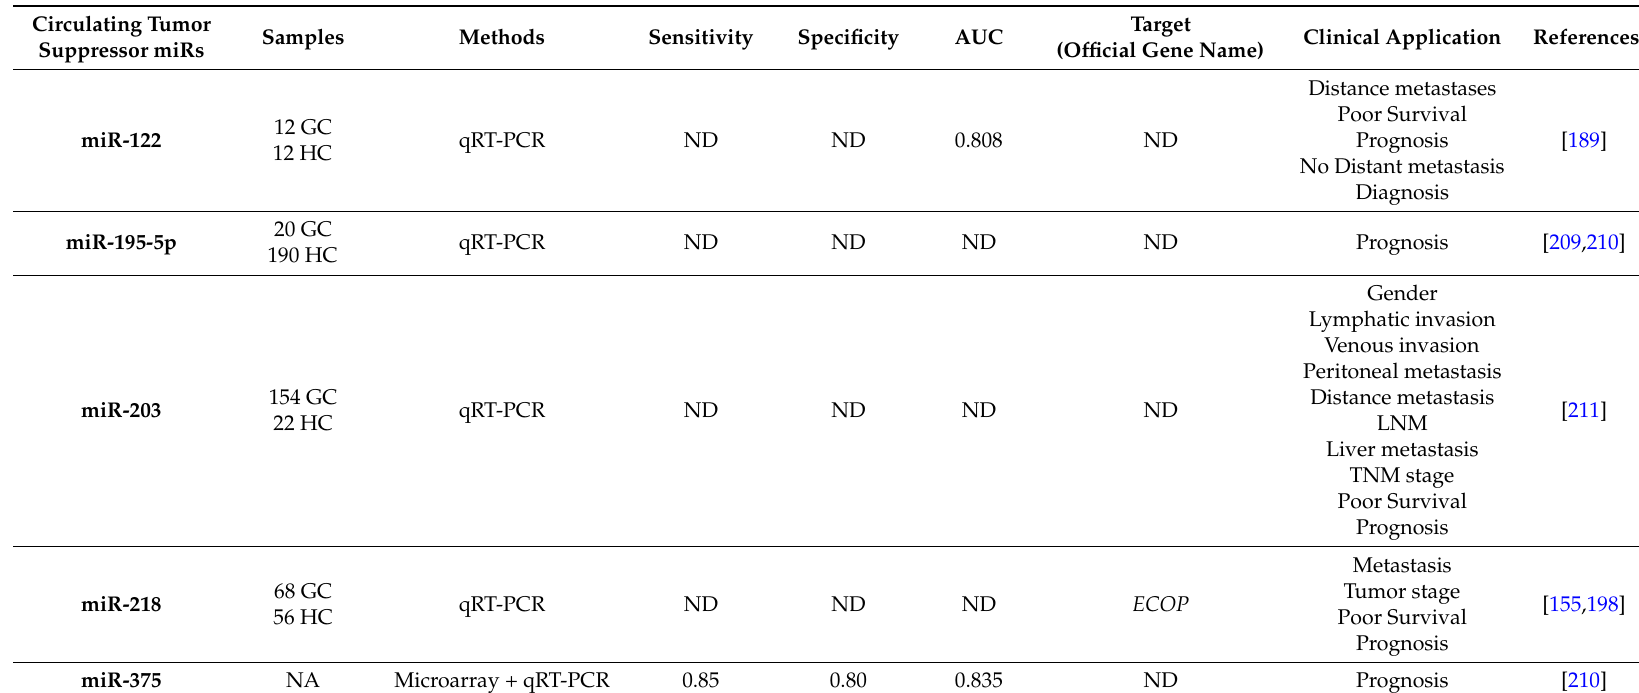
Table 4. Down-regulated circulating miRNAs for